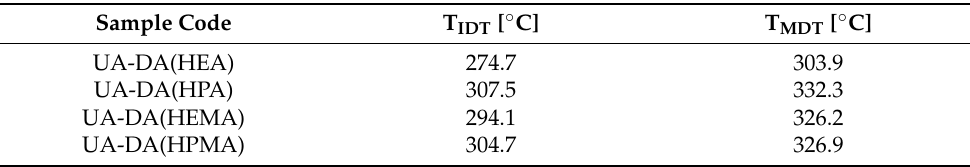
Table 4. Thermal stability of the obtained urethane